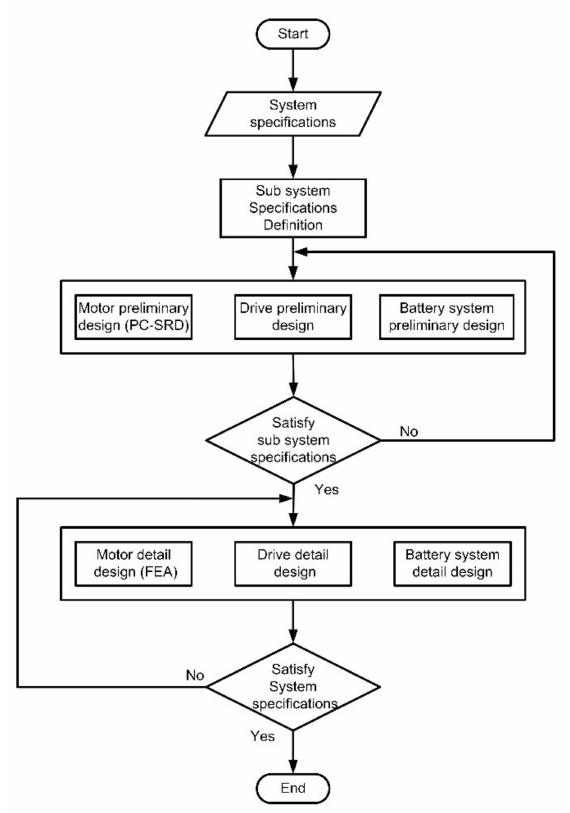
Figure 2. The flowchart of the electric motorcycle design